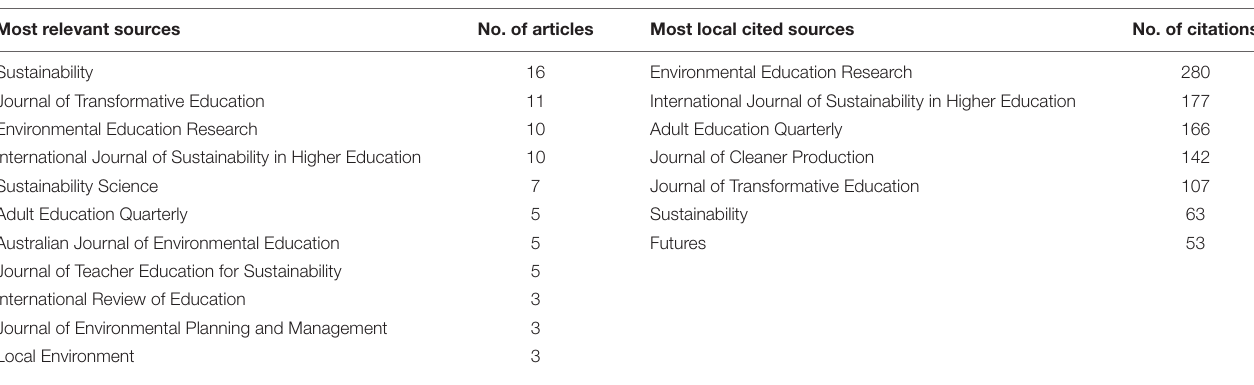
TABLE 2 | Most relevant sources and most local cited sources (prepared by authors). Most relevant sources No. of